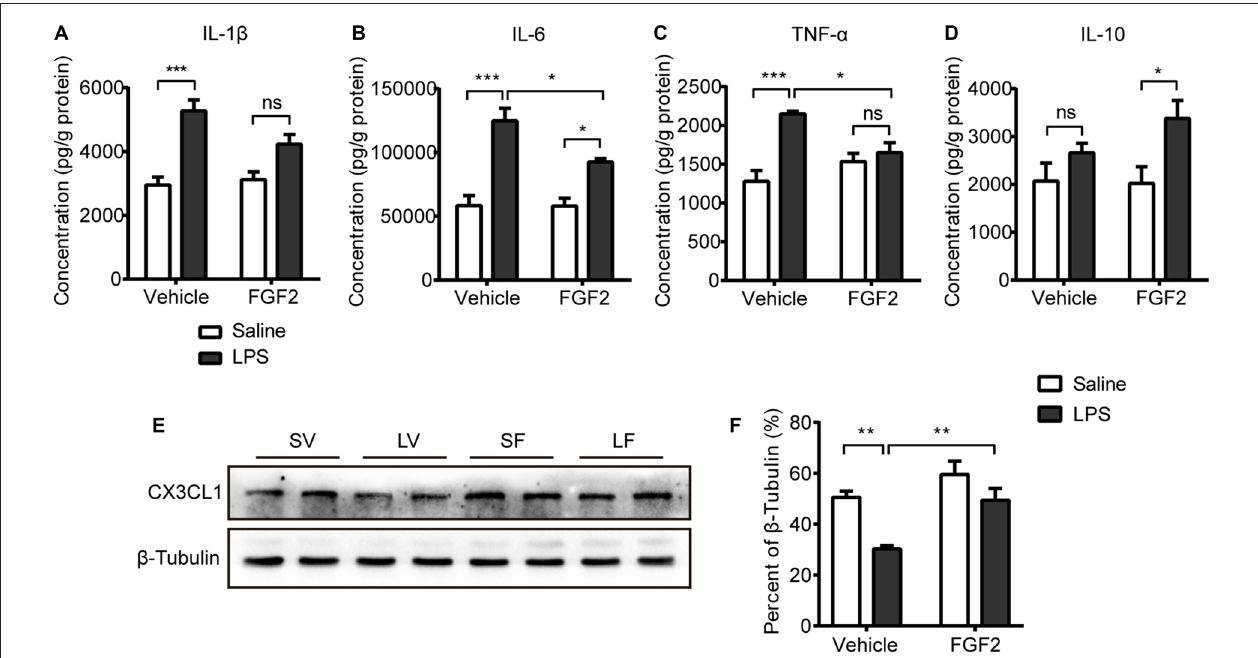
FIGURE 3 | Impact of LPS and FGF2 on cytokines and CX3CL1 expression in hippocampus. (A) The level of interlukin-1 β (IL-1 β ) was increased by LPS treatment. FGF2 prevented the IL-1 β upregulation after LPS treatment. (B) The level of IL-6 was increased by LPS treatment. FGF2 alleviated the IL-6 upregulation after LPS treatment. (C) The level of tumor necrosis factor- α (TNF- α ) was increased by LPS treatment. FGF2 reversed the increased TNF- α level induced by LPS treatment. (D) FGF2 increased the level of IL-10 in the LPS treated rats. (E) Representative western blots of CX3CL1 and corresponding normalized control β -Tubulin in hippocampus. (F) The expression of CX3CL1 was decreased by LPS treatment and was reversed by FGF2 infusions. Two-way ANOVA with Tukey’s multiple comparisons test, n = 5 or 6 per group. Data are presented as the means ± SEM. ∗ p < 0.05, ∗∗ p < 0.01, ∗∗∗ p < 0.001, ns non-significant. LPS, lipopolysaccharide; FGF2, fibroblast growth factor 2; SV, Saline + Vehicle; LV, LPS + Vehicle; SF, Saline + FGF2; LF, LPS +